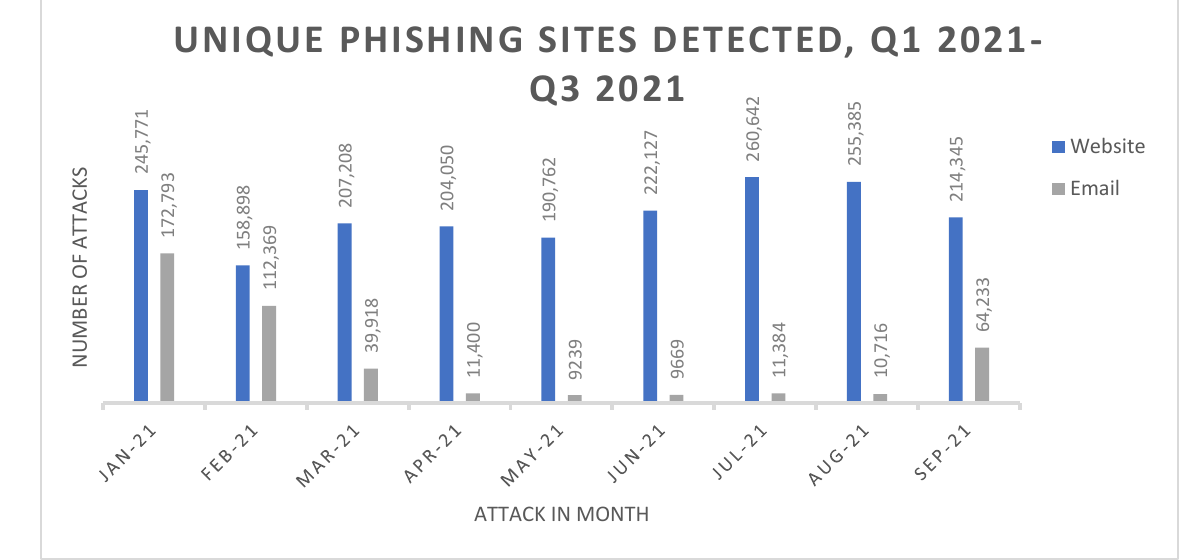
Figure 1. Detection of unique phishing sites [5].